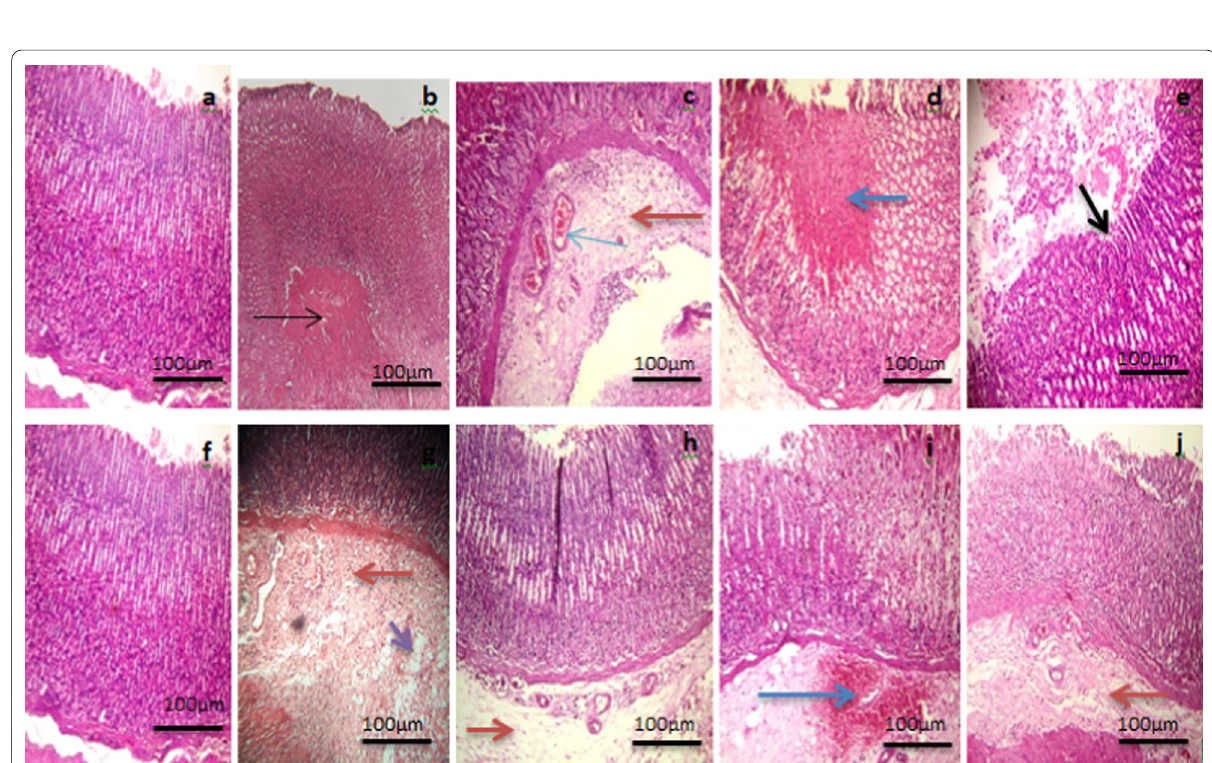
Fig. 9 Effects of folic acid and Omeprazole on the cyto-architectural alteration induced by acetic acid in the rat’s stomach at day 5 and 10. a Normal stomach: No significant lesion, surface epithelial is intact. b Acetic acid treated (day 5): Severe ulceration involving the mucosa and submucosa with the production of cellular debris, there is replacement of the submucosa by connective tissue fibers. (Thin black arrow: fibrosis). c folic acid (2 mg/kg) treated (day 5): Mild congestion of the mucosa (thin blue arrow), severe oedema (orange arrow) of the submucosa. d Folic acid (3 mg/ kg) treated (day 5): Moderate haemorrhage in the mucosa (blue arrow). e Omeprazole treated (day 5): Mild erosion of surface epithelial (black arrow) and mild inflammation of mucosa and submucosa. f Normal stomach (day 10): No significant lesion, surface epithelial is intact. g Acetic acid treated (day 10): Moderate ulcer, moderate infiltration of inflammatory cells within the mucosa, lamina propia and submucosa layer (Orange arrow: edema; Purple arrow: adipocytes). h Folic acid (2 mg/kg) treated (day 10): Mild oedema (orange arrow), mild inflammation of mucosa and submucosa. i Folic acid (3 mg/kg) treated (day 10): Moderate haemorrhage (blue arrow) of submucosa with mild inflammation of mucosa and submucosa. j Omeprazole treated (day 10): Slight oedema and slight inflammation of mucosa and submucosa (orange arrow). Surface epithelial is moderately preserved. (H & E, X100)